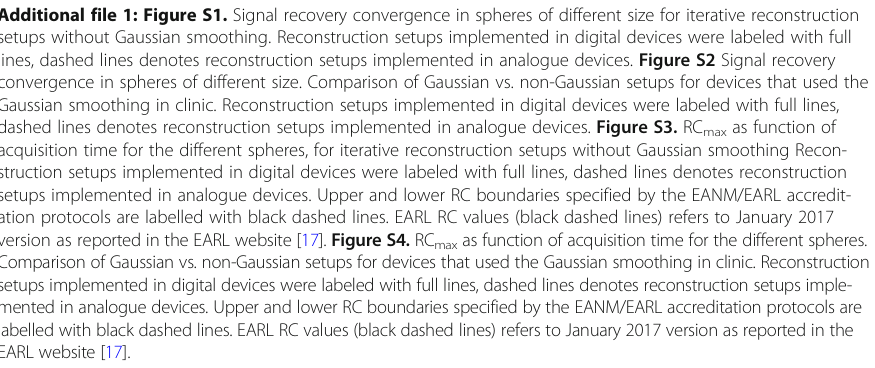
Additional file 1: Figure S1. Signal recovery convergence in spheres of different size for iterative reconstruction setups without Gaussian smoothing. Reconstruction setups implemented in digital devices were labeled with full lines, dashed lines denotes reconstruction setups implemented in analogue devices. Figure S2 Signal recovery convergence in spheres of different size. Comparison of Gaussian vs. non-Gaussian setups for devices that used the Gaussian smoothing in clinic. Reconstruction setups implemented in digital devices were labeled with full lines, dashed lines denotes reconstruction setups implemented in analogue devices. Figure S3. RC max as function of acquisition time for the different spheres, for iterative reconstruction setups without Gaussian smoothing Recon- struction setups implemented in digital devices were labeled with full lines, dashed lines denotes reconstruction setups implemented in analogue devices. Upper and lower RC boundaries specified by the EANM/EARL accredit- ation protocols are labelled with black dashed lines. EARL RC values (black dashed lines) refers to January 2017 version as reported in the EARL website [17]. Figure S4. RC max as function of acquisition time for the different spheres. Comparison of Gaussian vs. non-Gaussian setups for devices that used the Gaussian smoothing in clinic. Reconstruction setups implemented in digital devices were labeled with full lines, dashed lines denotes reconstruction setups imple- mented in analogue devices. Upper and lower RC boundaries specified by the EANM/EARL accreditation protocols are labelled with black dashed lines. EARL RC values (black dashed lines) refers to January 2017 version as reported in the EARL website